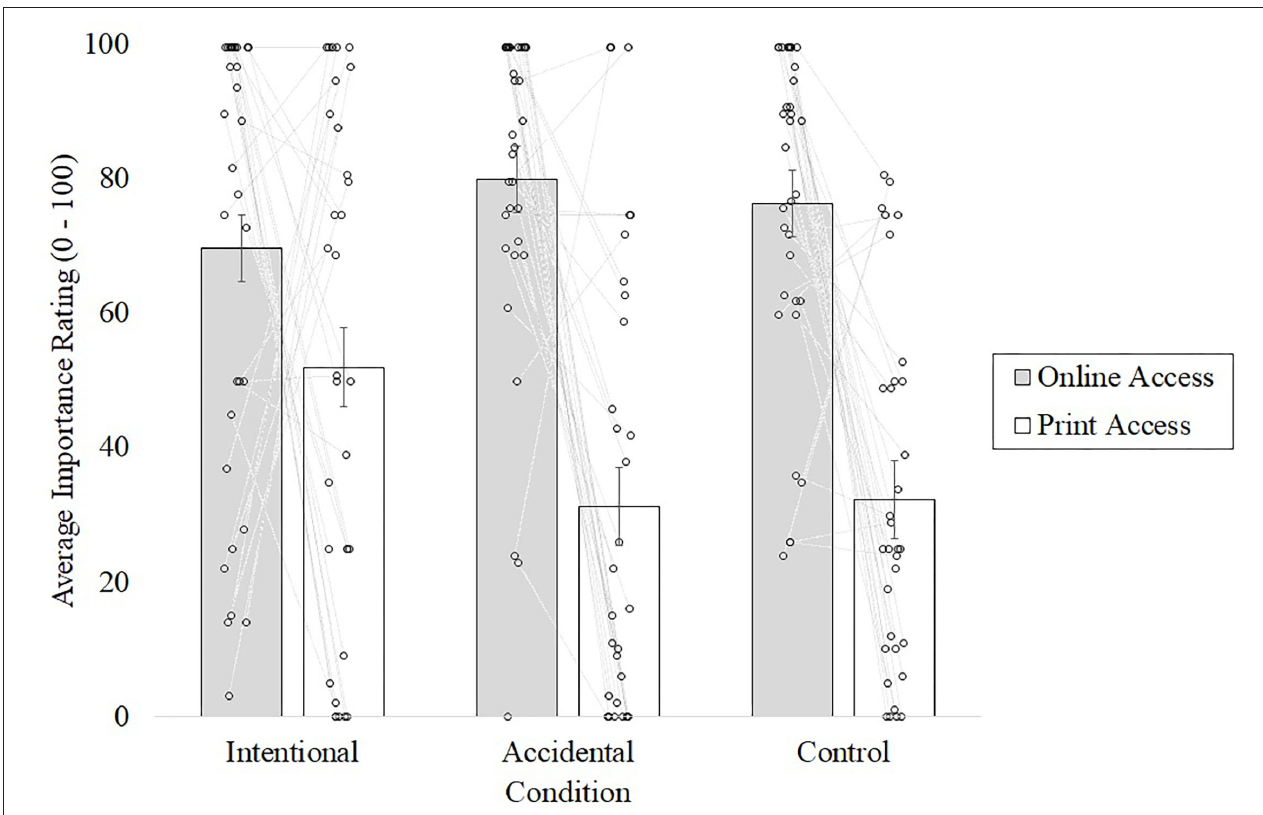
FIGURE 4 | Participants’ ratings of feature importance from Experiment 2. Error bars represent the SE per choice, within the condition. Each individual dot represents an individual participant’s rating as per the respective column, with links between their ratings of the two access types—online and print. Here, participants rated the availability of “online access” similarly across conditions, F (2, 94) = 1.09, p = 0.341, and η 2 = 0.023. However, participants rated the availability of “print access” significantly higher in the Intentional condition, F (2, 94) = 3.99, p = 0.022, and η 2 =